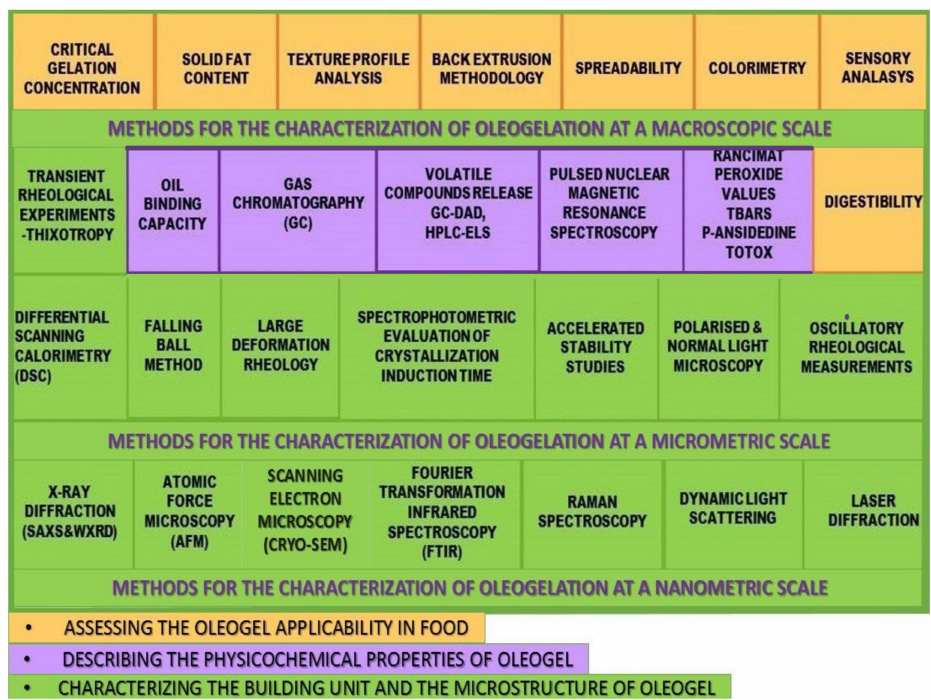
Figure 1. A proposed overview classification of the analytical methods of oleogel